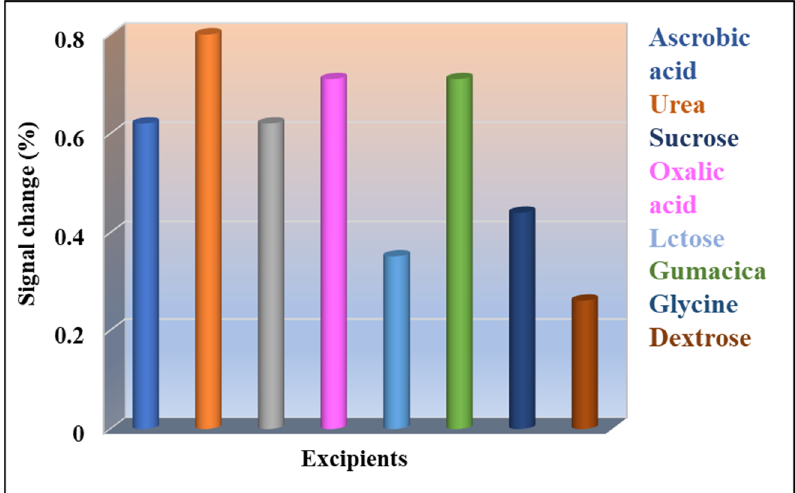
Figure 8. Effect of excipients on the potential values of the THP in the CuO-GO/CPE.